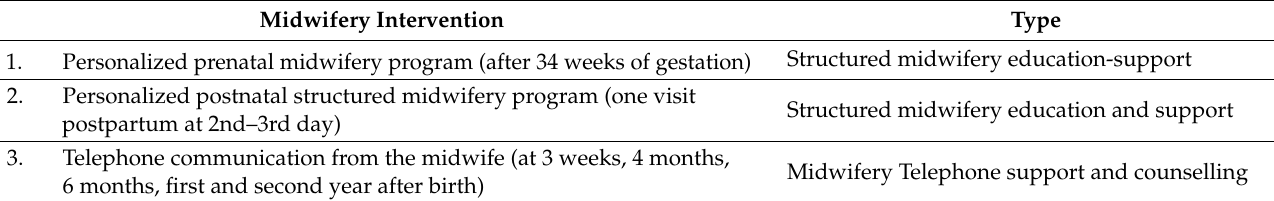
Table 1. The phases and the issues of the structured midwifery